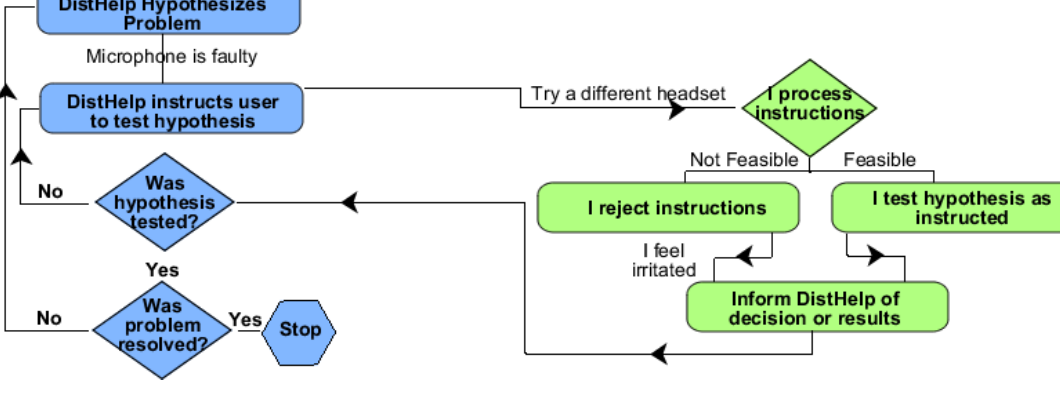
Figure 1 . Troubleshooting feedback